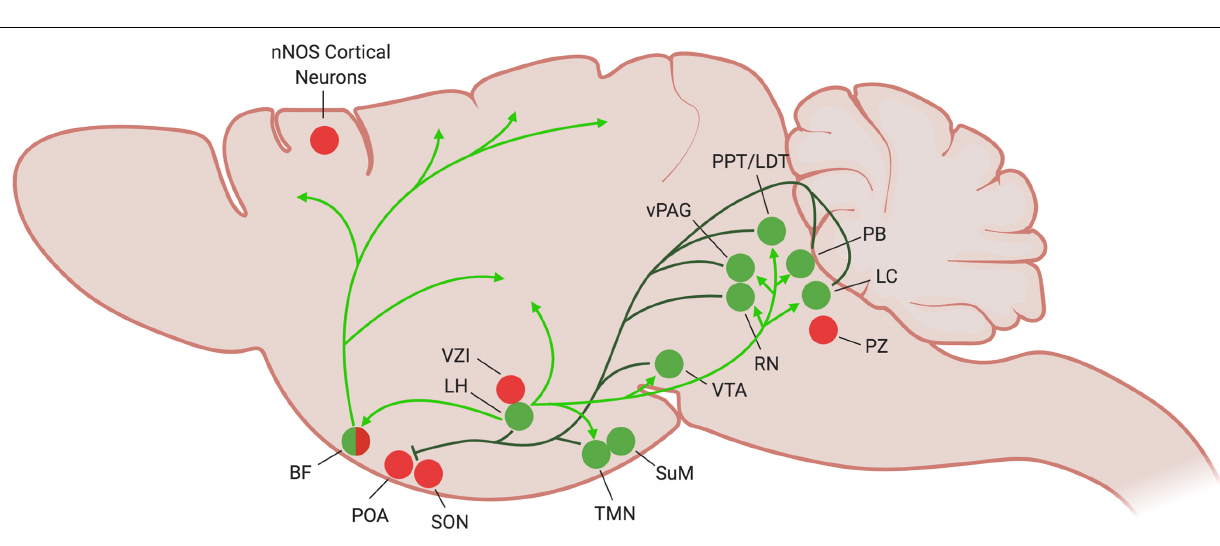
FIGURE 2 | Current understanding of wake-promoting circuitry in the mouse brain. During periods of wake, the wake-promoting nuclei (green circles) become active and inhibit sleep-promoting regions (dark green lines), particularly the POA. Inhibitory projections to other sleep-promoting regions have yet to be established. The orexinergic LH stabilizes the wake state by exciting many of the wake-promoting areas (light green arrows). Many of the wake-promoting regions (LH, TMN, SuM, RN, vPAG, LC) also promote wakefulness by activating the cortex, as illustrated by the BF (light green arrows). Figure created with